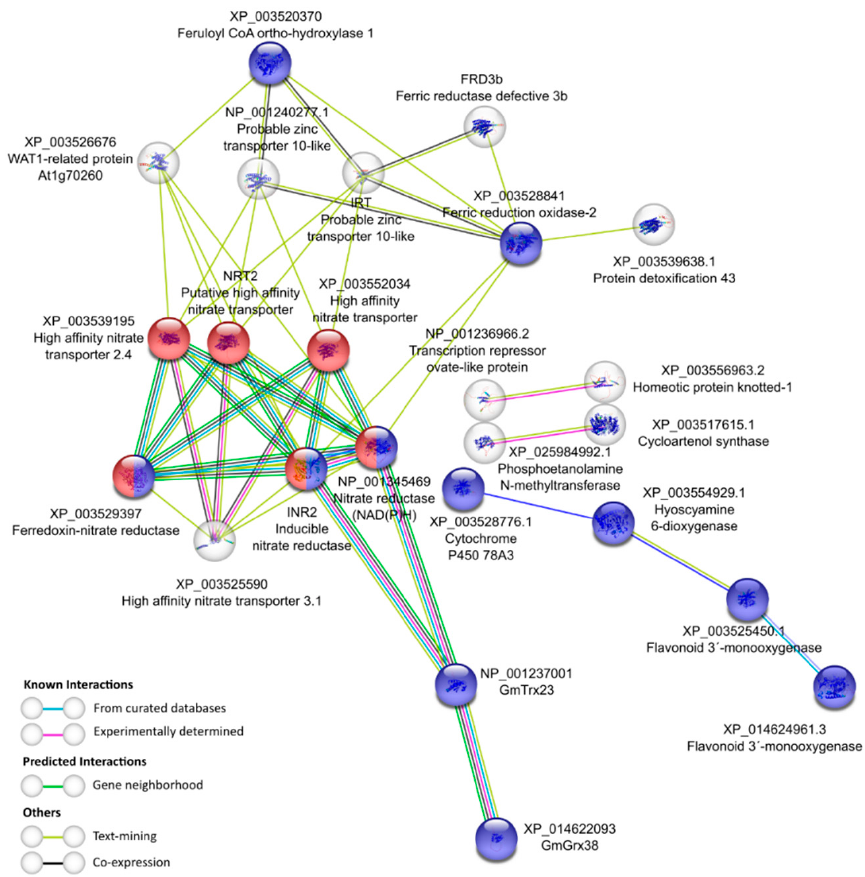
Figure 6. String analysis [41] derived protein-protein interaction network obtained for the differen- tially expressed genes down-regulated at the TOTAL+PAR level in nodulated and water-restricted plants with respect to non-nodulated and water-restricted plants (N+WR vs. NN+WR contrast). The network nodes represent proteins. Connecting lines denote protein-protein associations whose colors represent the type of interaction evidence as specified in the legend. Red proteins: KEGG Pathway functional term “Nitrogen metabolism (Gmx00901)”; Blue proteins: GO functional term “Oxidation-reduction process (GO:0055114)”. Disconnected nodes, i.e., proteins not showing any interaction in the network, were